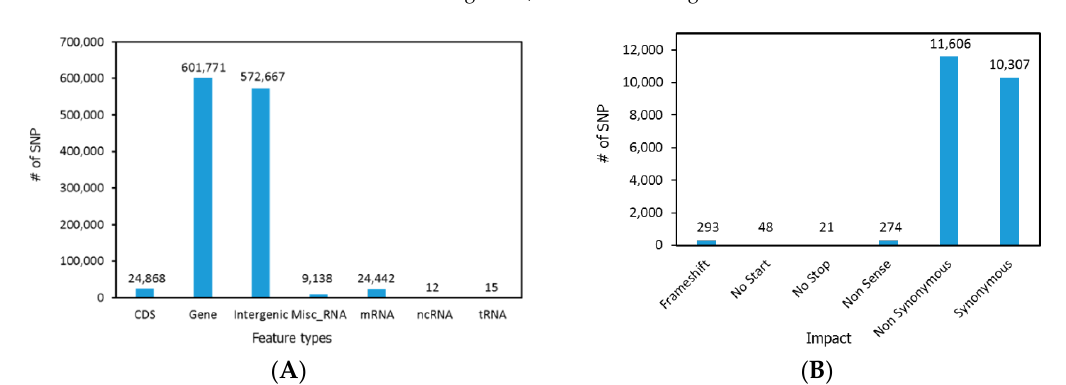
Figure 1. Distribution of single nucleotide polymorphisms (SNPs) in different regions of genome ( A ) and SNPs associated with different types of mutations ( B ). CDS: Coding DNA sequences; mRNA: Messenger RNA; ncRNA: Non-coding RNA; tRNA: Transfer RNA.